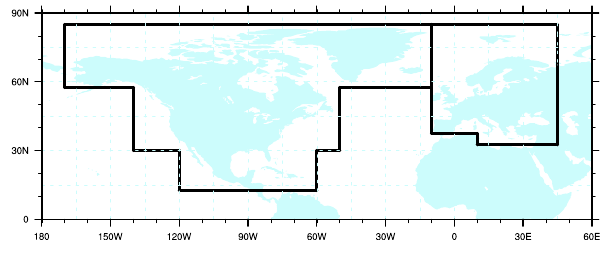
Fig. 2. Depiction of the regions used for the computation of emis-